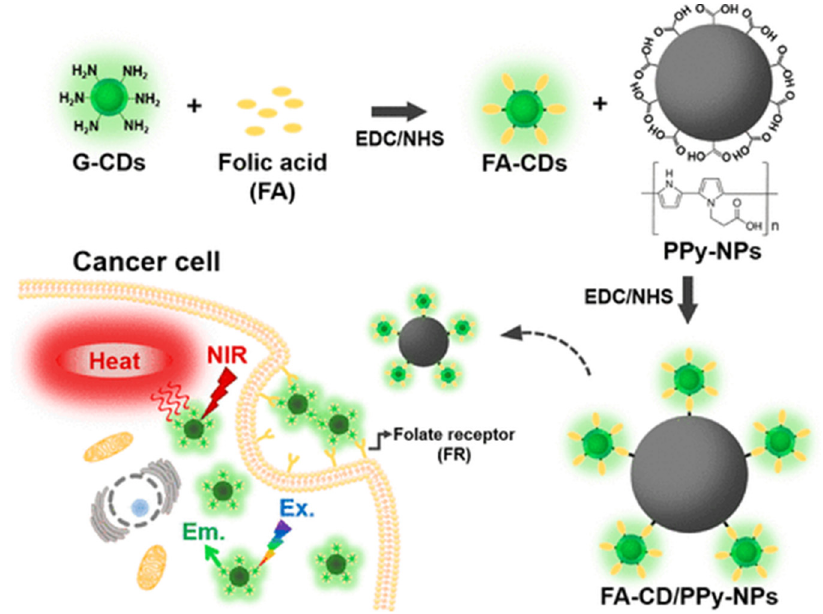
Figure 8. Simultaneous bioimaging and photothermal therapy by folic acid functionalized carbon dots/polypyrrole nanoparticle (FA-CD/PPy-NP) complexes [108]. Copyright 2021, ACS.